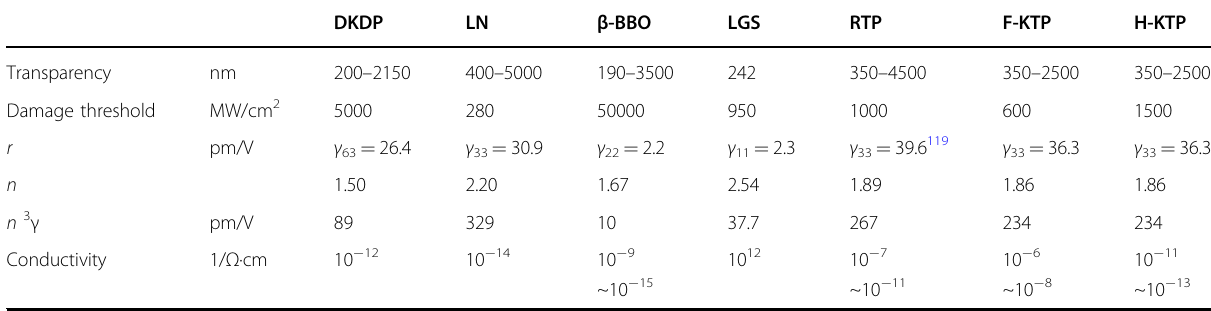
Table 1 Electro-optic performance comparison of KTP and other proven EO crystals